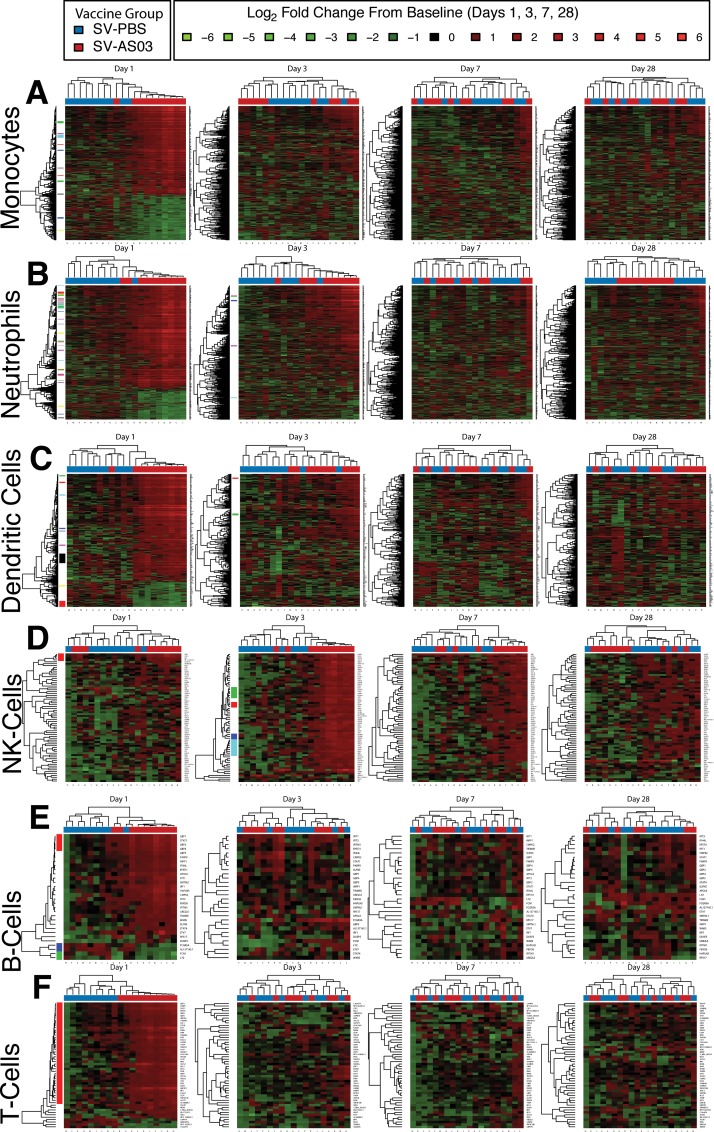
AS03-adjuvanted H5N1 vaccination primarily modulated early innate immune cell gene expression responses.Heatmaps of baseline log2 fold changes of DE genes for each cell type at each post-vaccination time point (A: monocytes, B: neutrophils, C: DC, D: NK cells, E: B cells, F: T cells). Dendograms were obtained using complete linkage clustering of uncentered pairwise Pearson correlation distances between log2 fold changes. Co-expressed gene cluster membership based on multiscale bootstrapping is highlighted along the gene dendogram on the left side. Cells are color-coded by log2 fold change (in red: upregulated from baseline; in green: downregulated from baseline.